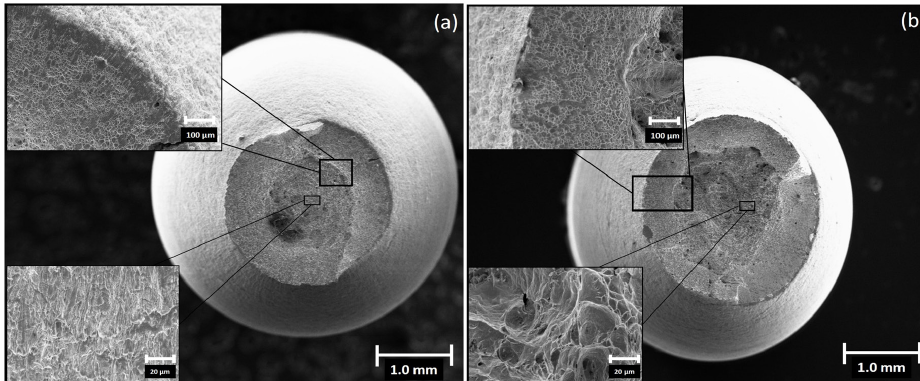
Figure 4. Fractography of ST specimens in air environment of maraging (a) M300 and (b) M350.